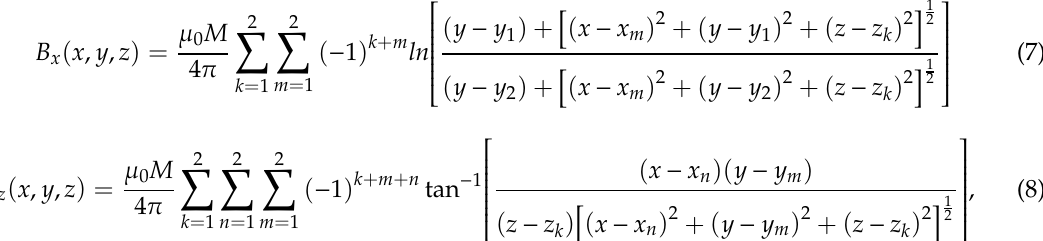
Figure 8. ( a ) Schematic representation of the interaction among the core-shell magnetic nanoparticle and the magnetoelastic ribbon. 𝑴 is the magnetization of the ME ribbon, 𝒎 is the magnetic moment of the core-shell nanoparticle and r indicates the position in the chosen reference system. ( b , c ).Intensity of the x and z components x of the magnetic induction field ( B x and B x ) in the symmetry plane x-z of the ribbon (y = 0.5 mm).